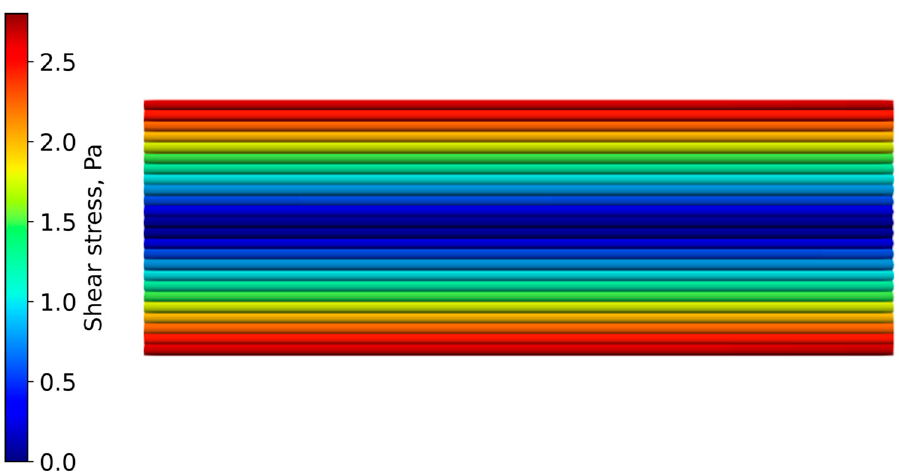
Figure 4. Shear stresses characteristic of defined particles’ trajectories in the cross-section of the tubing lengthwise. Follow the color scale from blue (low shear stress) to red (high shear stress).